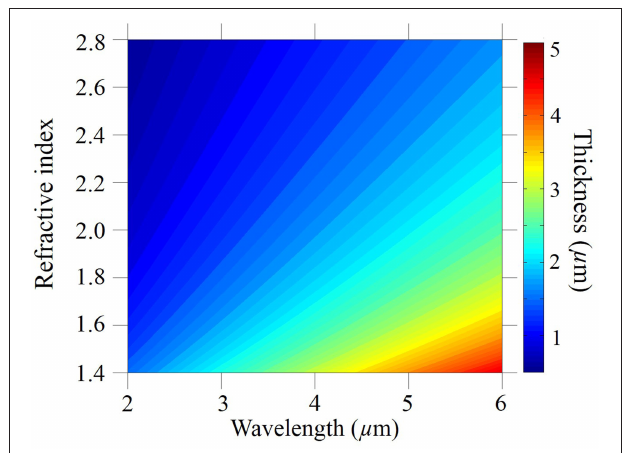
FIGURE 3 | Contour plot of the tube thicknesses that satisfy the antiresonance condition, t = ( m − 0.5) λ/ [2( n 2 1 − n 2 0 ) 1 / 2 ] , where m = 2 .